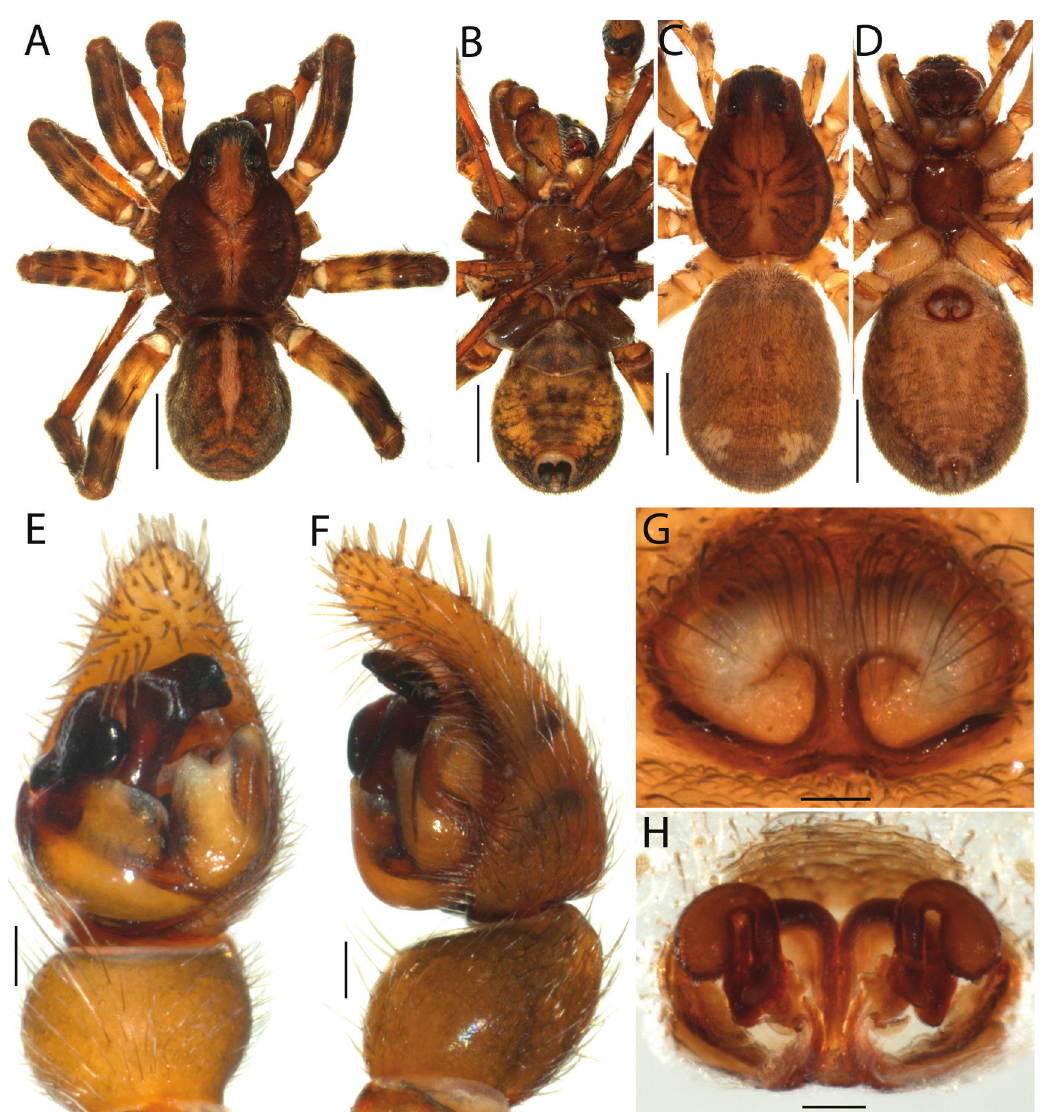
Figure 43. Artoria victoriensis Framenau, Gotch & Austin, 2006, male (AM KS84363) and female (AM KS84744): A , male habi- tus, dorsal view; B , male habitus, ventral view; C , female habitus, dorsal view; D , female habitus, ventral view; E, male pedipalp, ventral view; F , male pedipalp, retrolateral view; G , epigyne, ventral view; H , epigyne, dorsal view. Scale bars: habitus 1.0 mm; pedipalp, epigyne 0.1